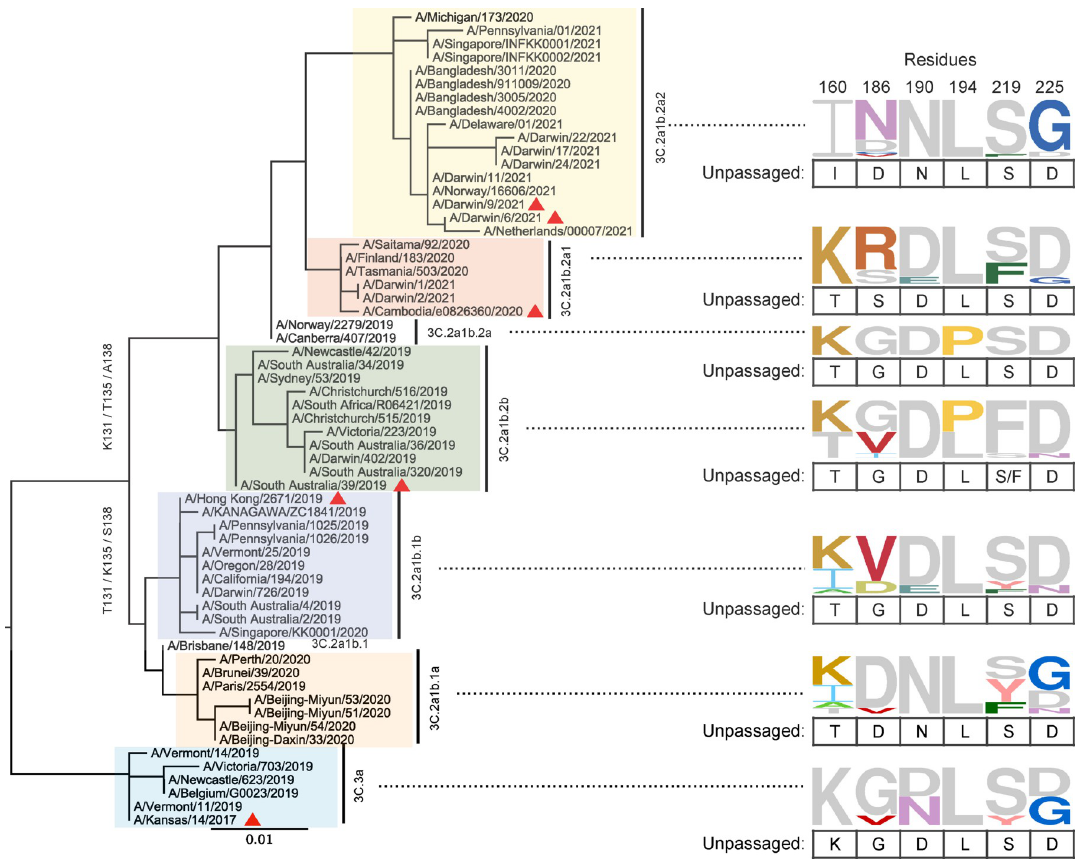
Fig 4. Egg-adaptive mutations in recent human H3N2 HA. A rooted phylogenetic tree was built using maximum likelihood (ML) method with 100 bootstraps on the HA sequences of 61 human H3N2 strains without egg-passaging (unpassaged strains). Different clades are highlighted in different colors. WHO-recommended vaccine strains are indicated by a red triangle symbol. These unpassaged human H3N2 strains correspond to the parental strains of 72 egg-passaged strains. Since multiple egg-passaged strains with different HA sequences could be generated from a single unpassaged strain, the number of unpassaged strains is less than that of egg- passaged strains. Frequencies of amino acids at HA residues 160, 186, 190, 194, 219 and 225 among egg-passaged strains in different clades are shown as sequence logos. The relative size of each amino acid letter represents its frequency in the sequences. For each clade, amino acid variants that are also observed in the unpassaged strains are in grey and listed below each sequence